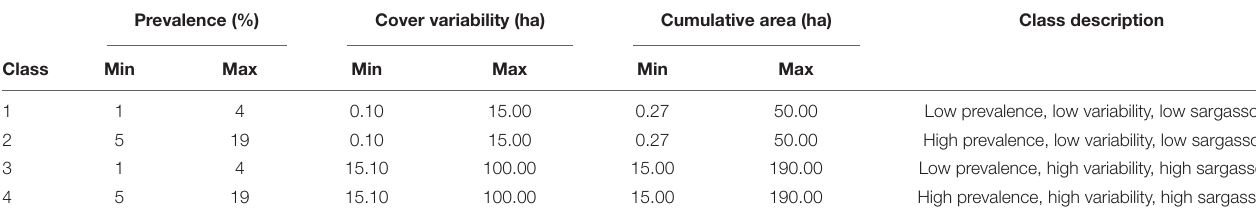
Prevalence (%) Cover variability (ha) Cumulative area (ha) Class